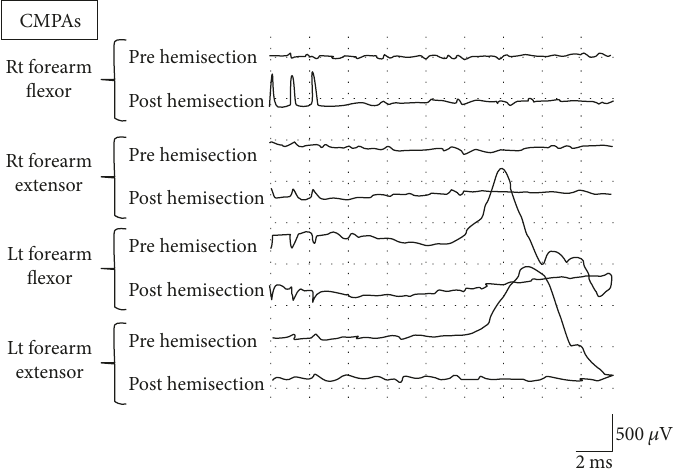
Figure 7: CMAPs obtained by stimulating the right pyramid of the rats for preliminary experiment having undergone left C5 segmental hemisection (stimulation intensity: 2T). Upper row: before hemisection; lower row: after hemisection. No electric potential of the left forelimb fl exor/extensor was recorded immediately after the